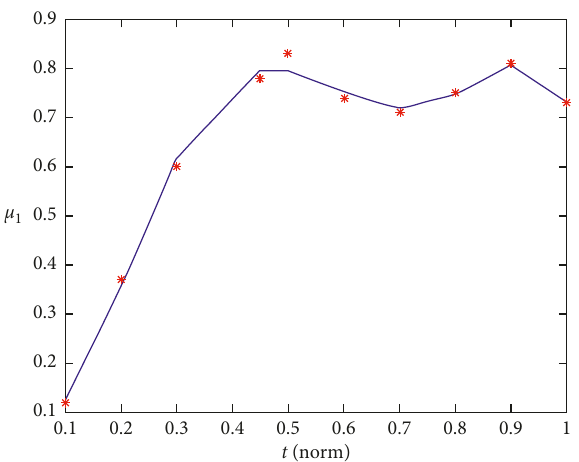
Figure 4: Data fitting of ( μ